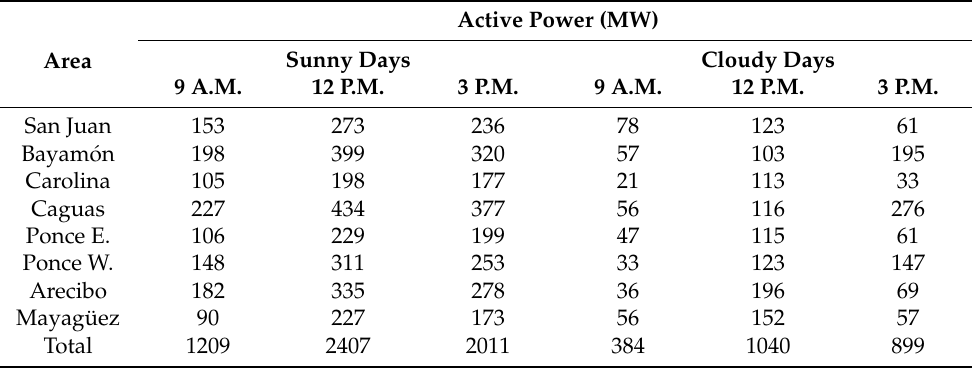
Table 16. Potential PV production by area (30% of PV penetration).